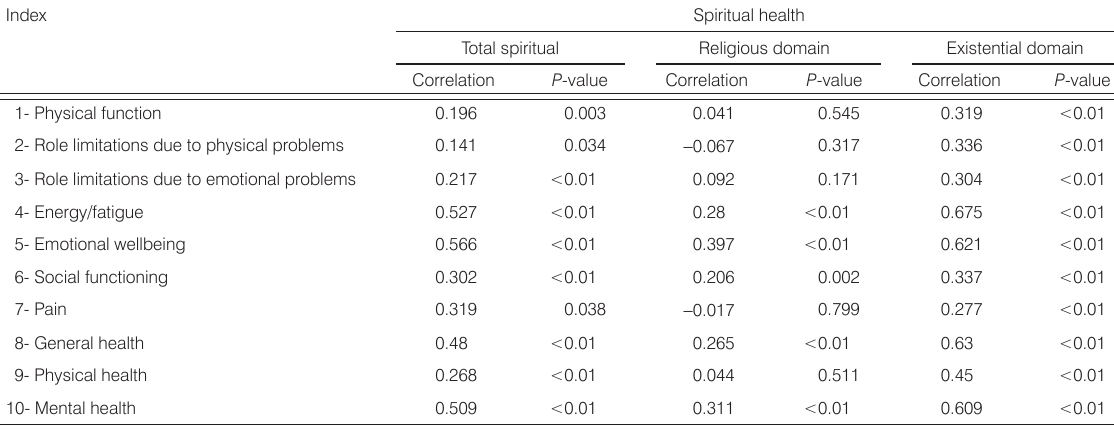
Table 1. The relationship between spiritual well-being and QoL